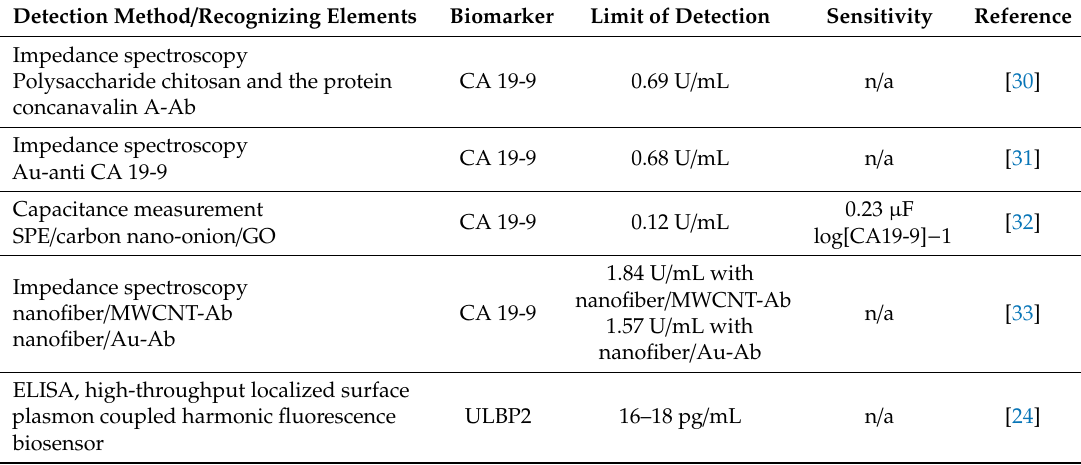
Table 1. Electrochemical biosensors for the detection of PC